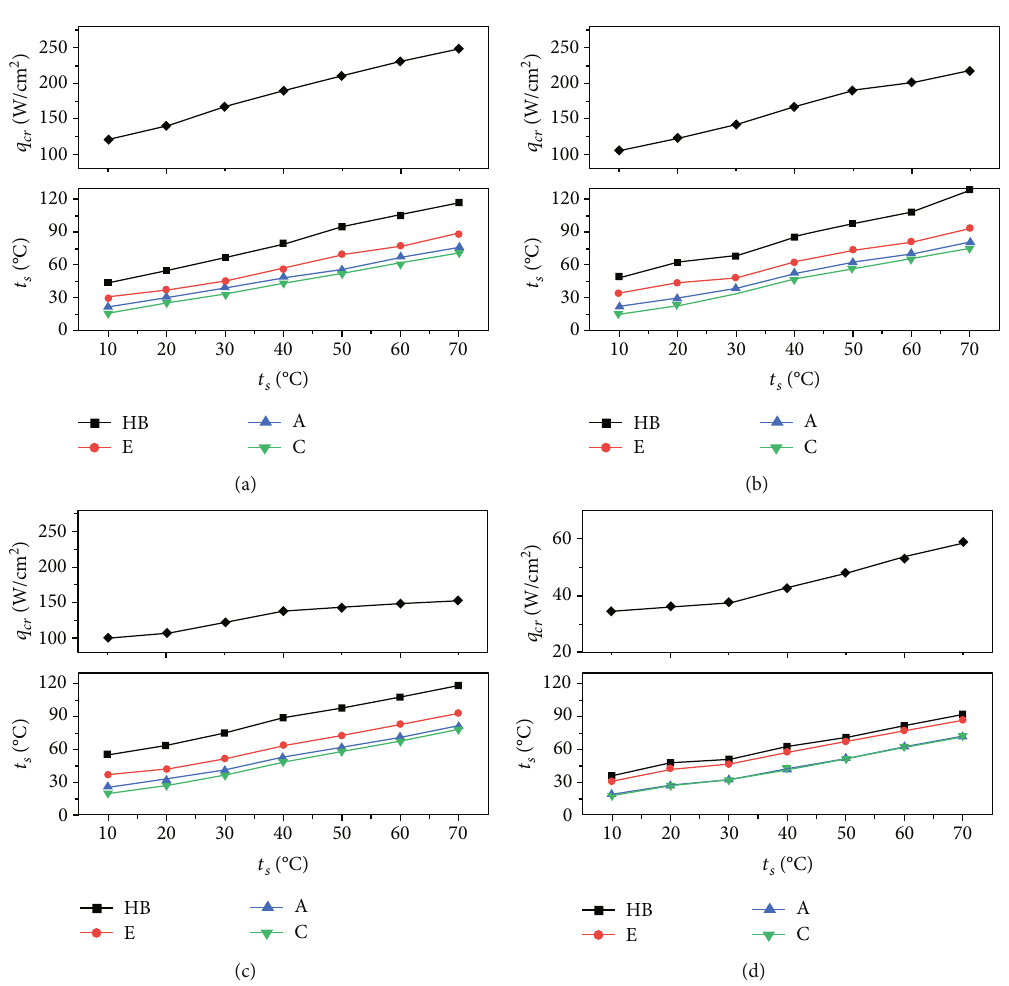
Figure 3: The critical heat fl ux and working temperature of a bent copper-water heat pipe with di ff erent evaporator and condenser lengths: (a) L e = 3 cm , L c = 7 cm , (b) L e = 2 cm , L c = 7 cm , (c) L e = 2 cm , L c = 3 : 5 cm , and (d) L e = 1cm , L c = 3 : 5cm . HB: heating block; E: evaporation; A: adiabatic; C: